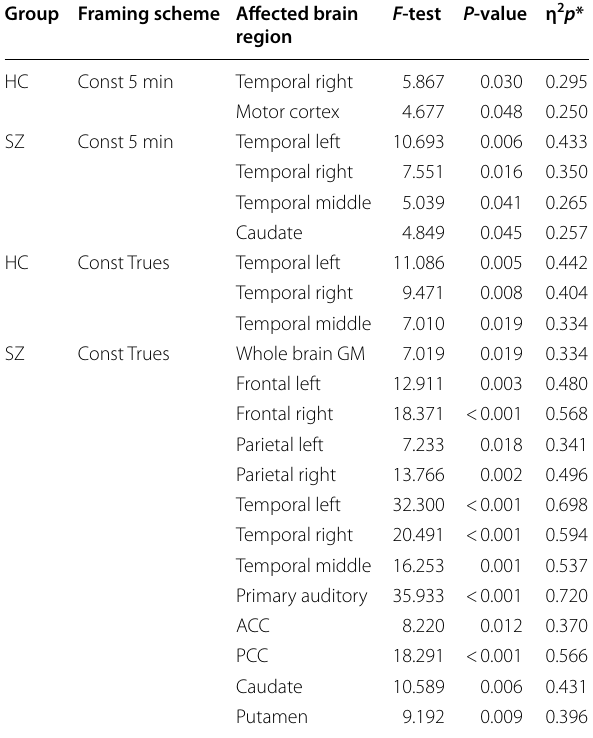
Table 2 Groups balanced by smoking status, age, gender and education for the analysis of smoking status effects on BP ND in HC and SZ grouped by framing scheme methods. The results from a pairwise analysis between subgroups (S and nS) for brain regions with significant differences reported